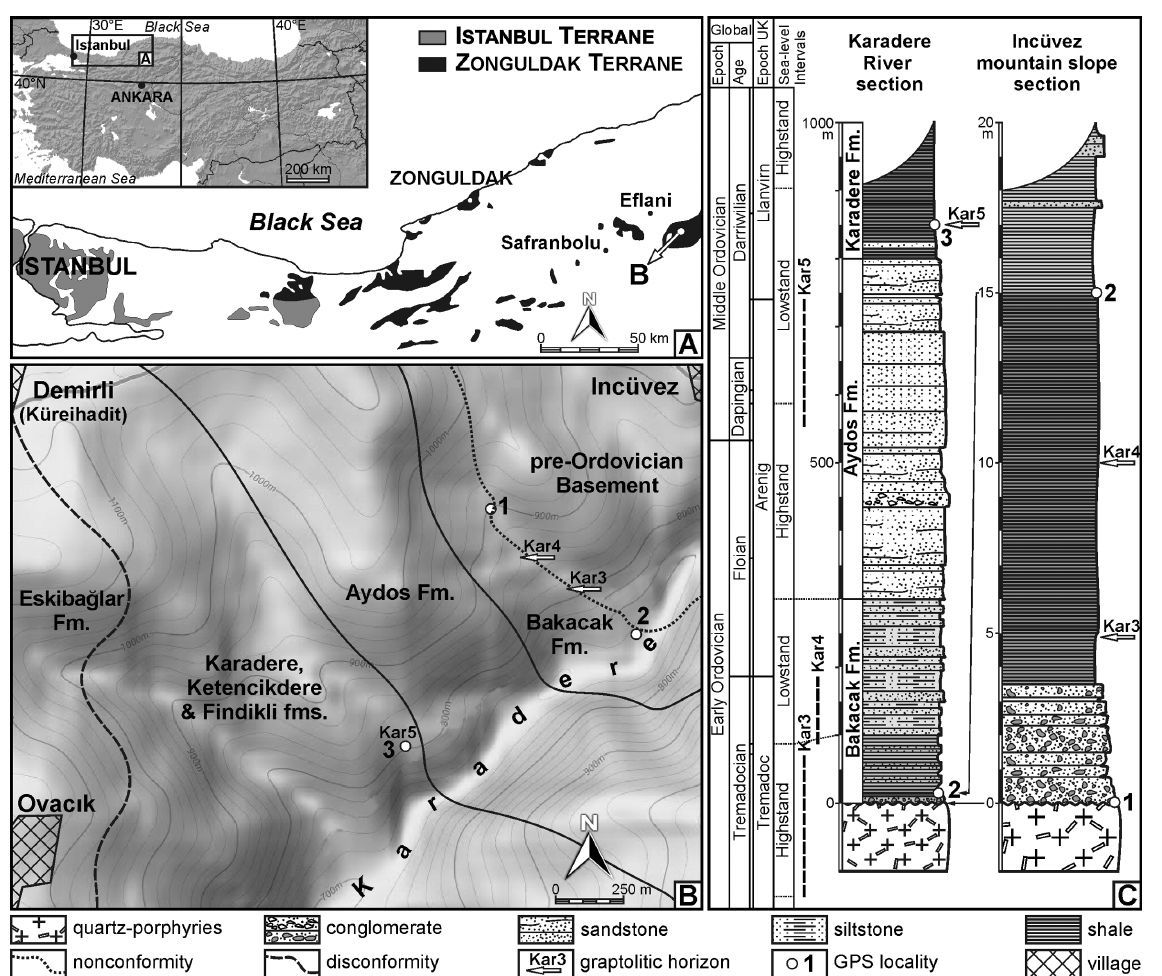
Fig. 1. A , distribution of Palaeozoic rocks in NW Anatolia (modified from G(cid:246)nc(cid:252)oglu et al. 2006); B , location of the studied successions. The geological map is modified from Boztu ğ (1992). The GPS localities of the starting and end points of the Inc(cid:252)ves section are: point 1 (41(cid:176)20 ′ 50.11 ″ N; 33(cid:176)04 ′ 43.98 ″ E) and point 2 (41(cid:176)20 ′ 34.98 ″ N; 33(cid:176)05 ′ 09.09 ″ E). The sample Kar5 from point 3 (41(cid:176)20 ′ 21.29 ″ N; 33(cid:176)04 ′ 30.27 ″ E). C , Ordovician litho- and chronostratigraphy of the studied sections and location of graptolite horizons Kar3, Kar4 and Kar5. The chronostratigraphy and sea-level intervals are by Cooper & Sadler